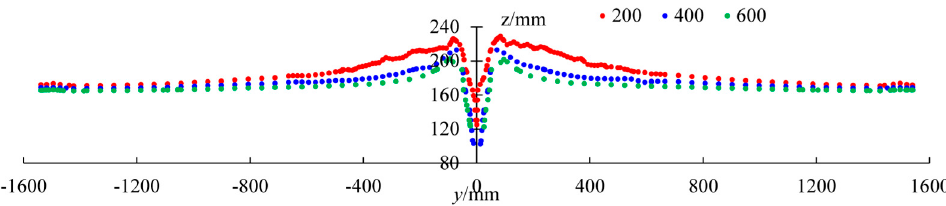
Figure 10. Free surface on the different cutting planes.